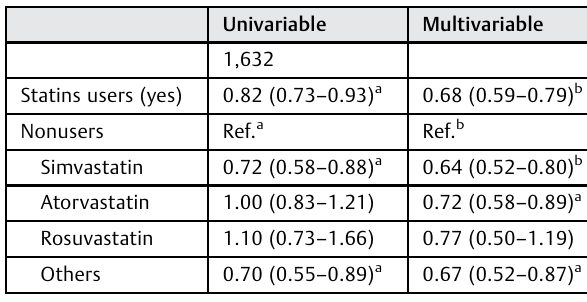
Table 5 Multivariable analyses for all-cause death